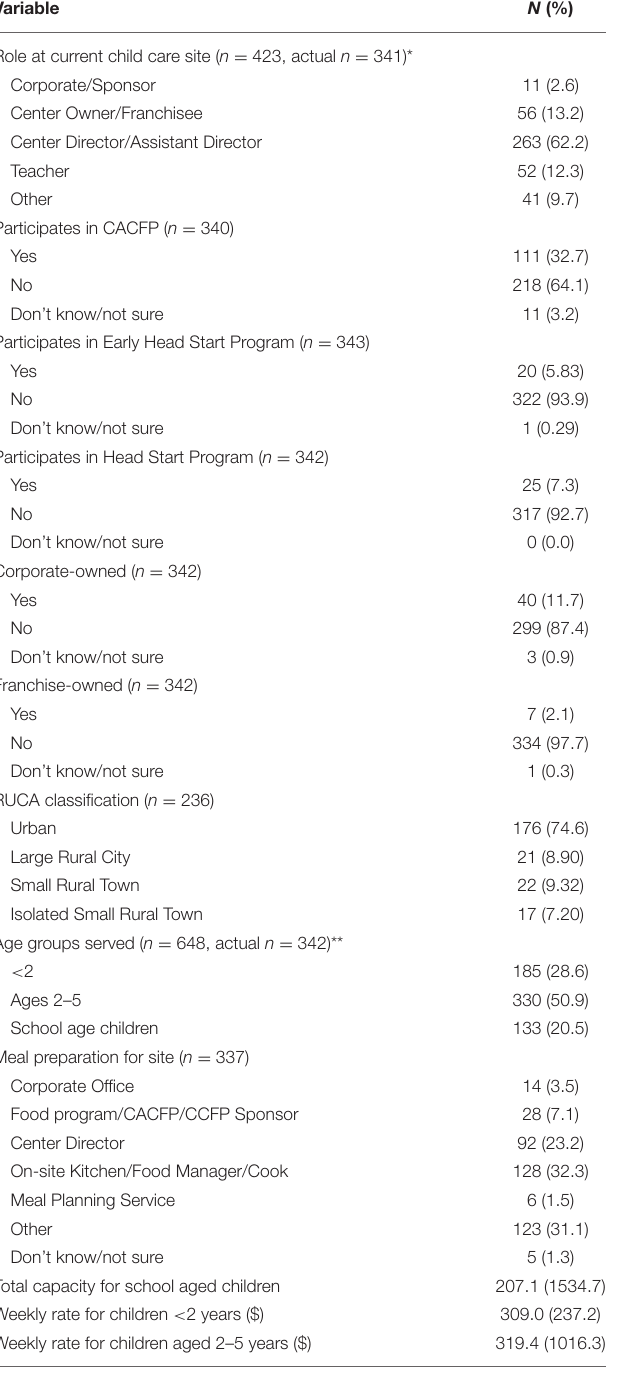
TABLE 3 | Number and percentage of self-reported food environment regulation